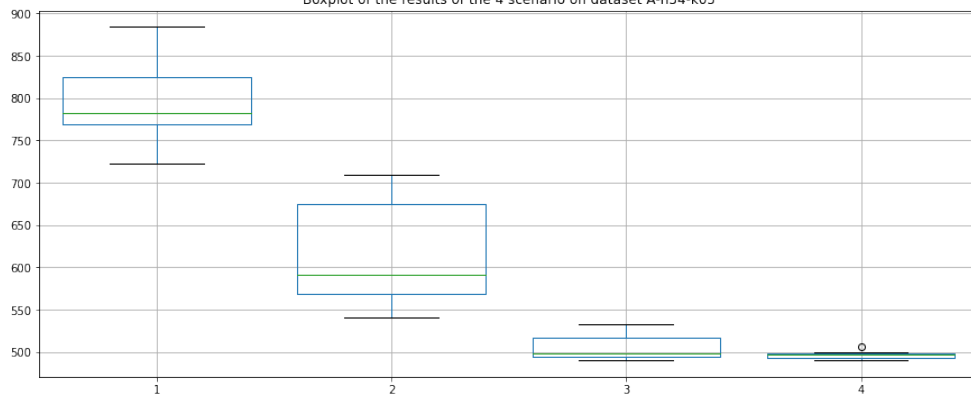
Figure 8. Boxplot of scenarios on the A-n34-k5 task of